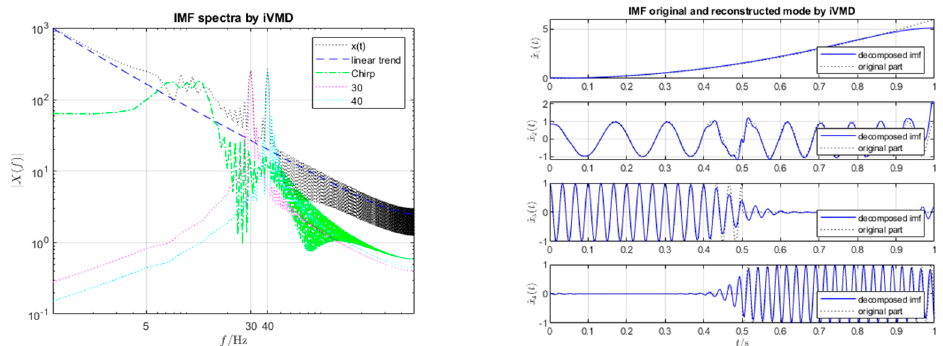
Figure 4. iVMD decomposition of x Sig2 ( t ) run via iVMD. The left figure shows the IMF’s spectra, and